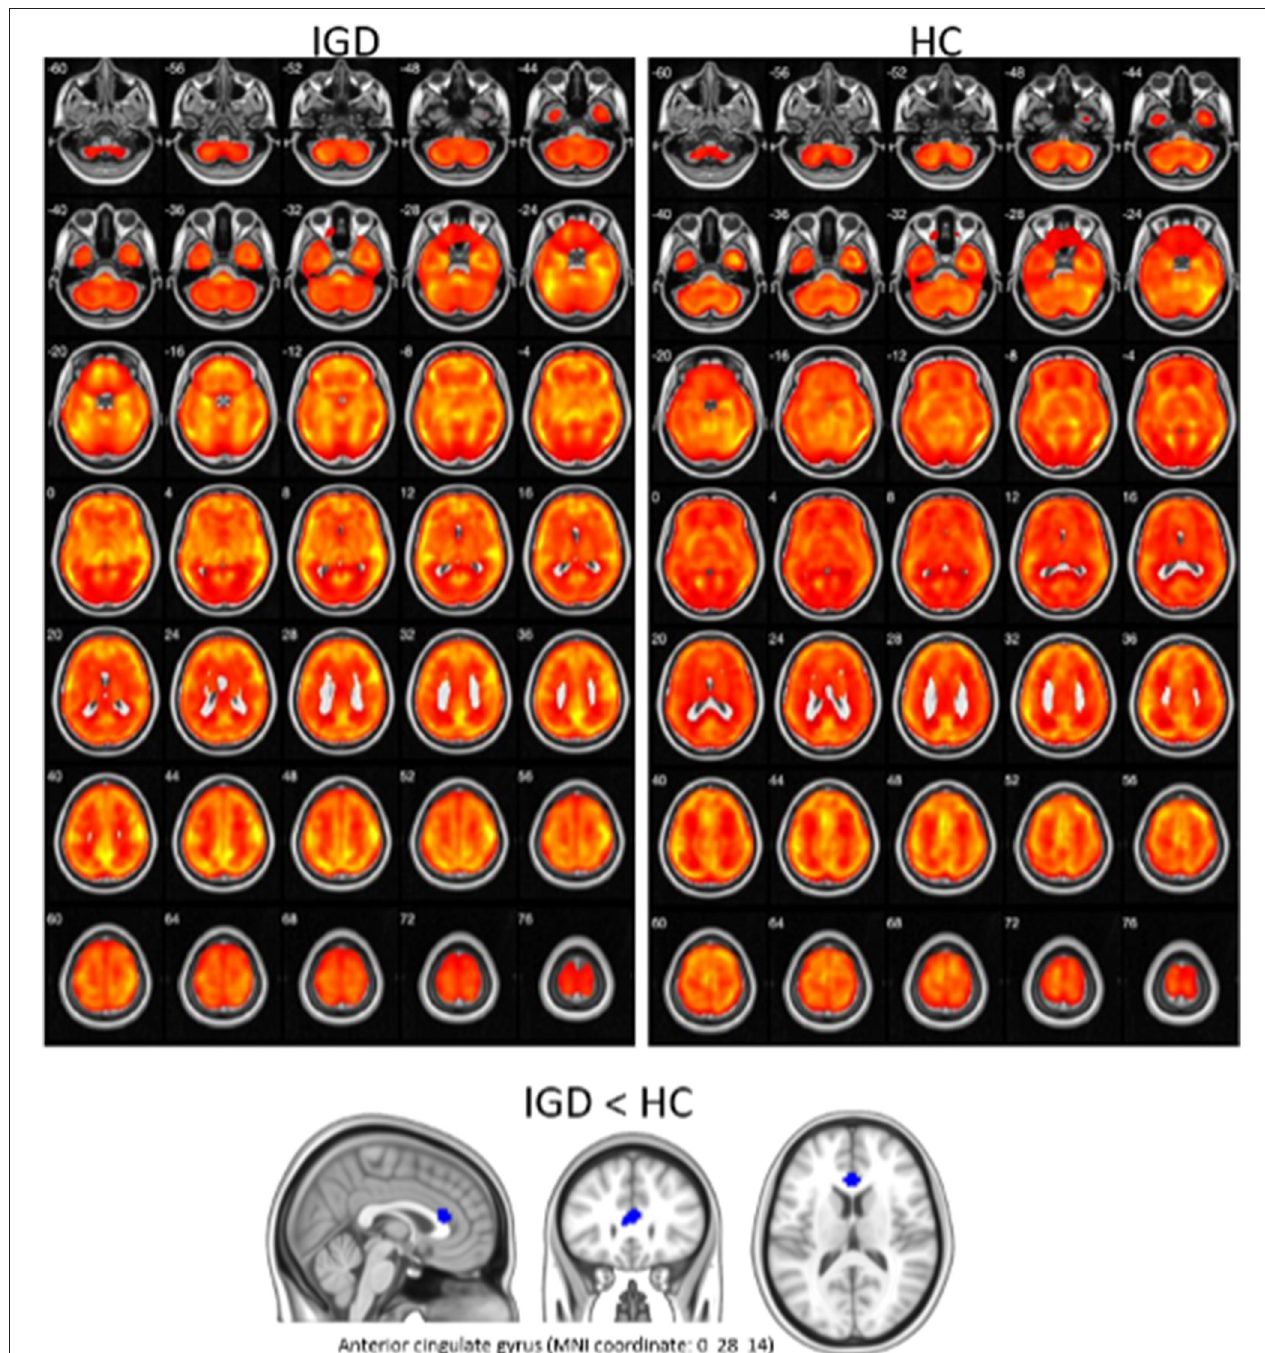
FIGURE 2 | Visualization of mean metabolic uptake of 18F -FDG-PET in IGD and HC. Top: areas showing significant glucose metabolism in both IGD and HC, using one-sample t-test (corrected p < 0.05, cluster size ( k ) > 100). Bottom: IGD showed lower glucose metabolism in anterior cingulate gyrus, compared with HC ( p < 0.005 uncorrected, k >